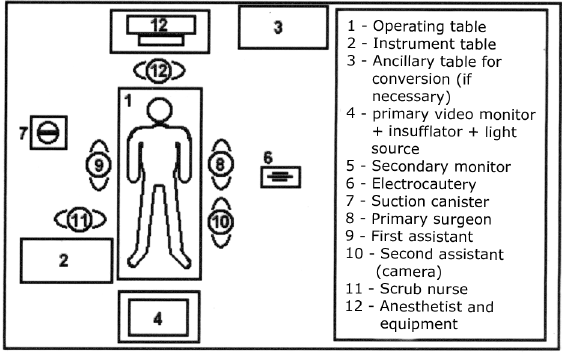
Figure 2 – Positioning of surgical staff in pelvic